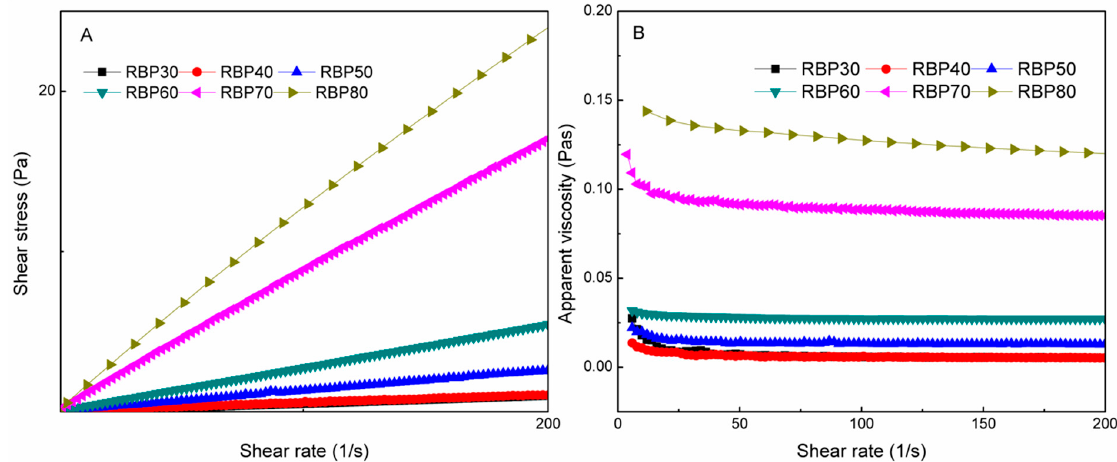
Figure 1. ( A ) Shear stress and ( B ) apparent viscosity of 2.0% (w/v) aqueous solutions of six fractional bletillae rhizome polysaccharides (RBPs) as a function of shear rate at 25 °C. The flow curves of 2.0% (w/v) aqueous solutions of the six fractional RBPs are shown in Figure 1. At the same shear rate, the shear stress of fractional RBP solution increased with increasing extraction temperature. Newtonian behavior of fractional RBP solutions (RBP30, RBP40, RBP50, and RBP60) extracted under low temperature (30–60 °C) was observed. Non-Newtonian or